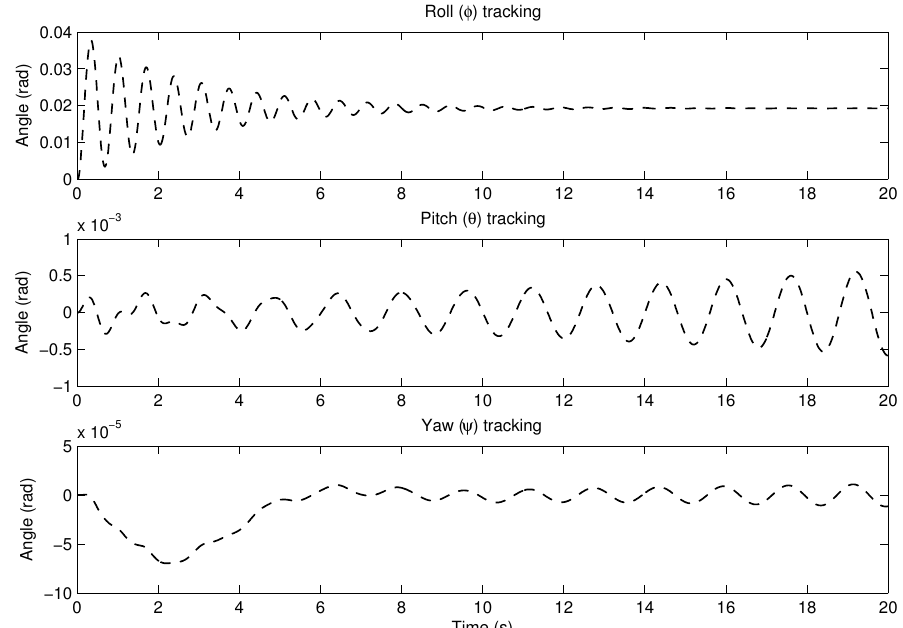
Figure 5. The nonlinear rotorcraft model response to selected trim control input.